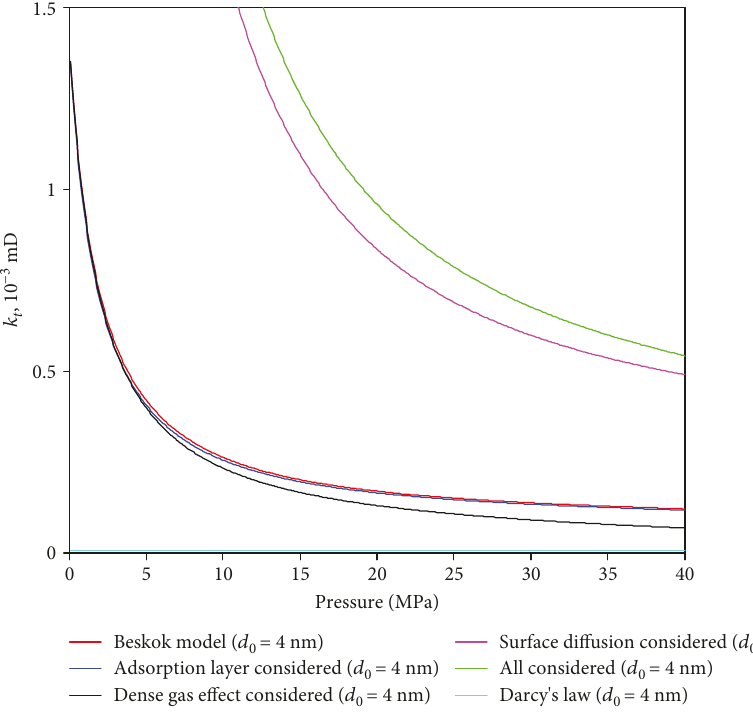
Figure 7: The e ff ect of di ff erent factors on total apparent permeability (pore diameter = 4 nm